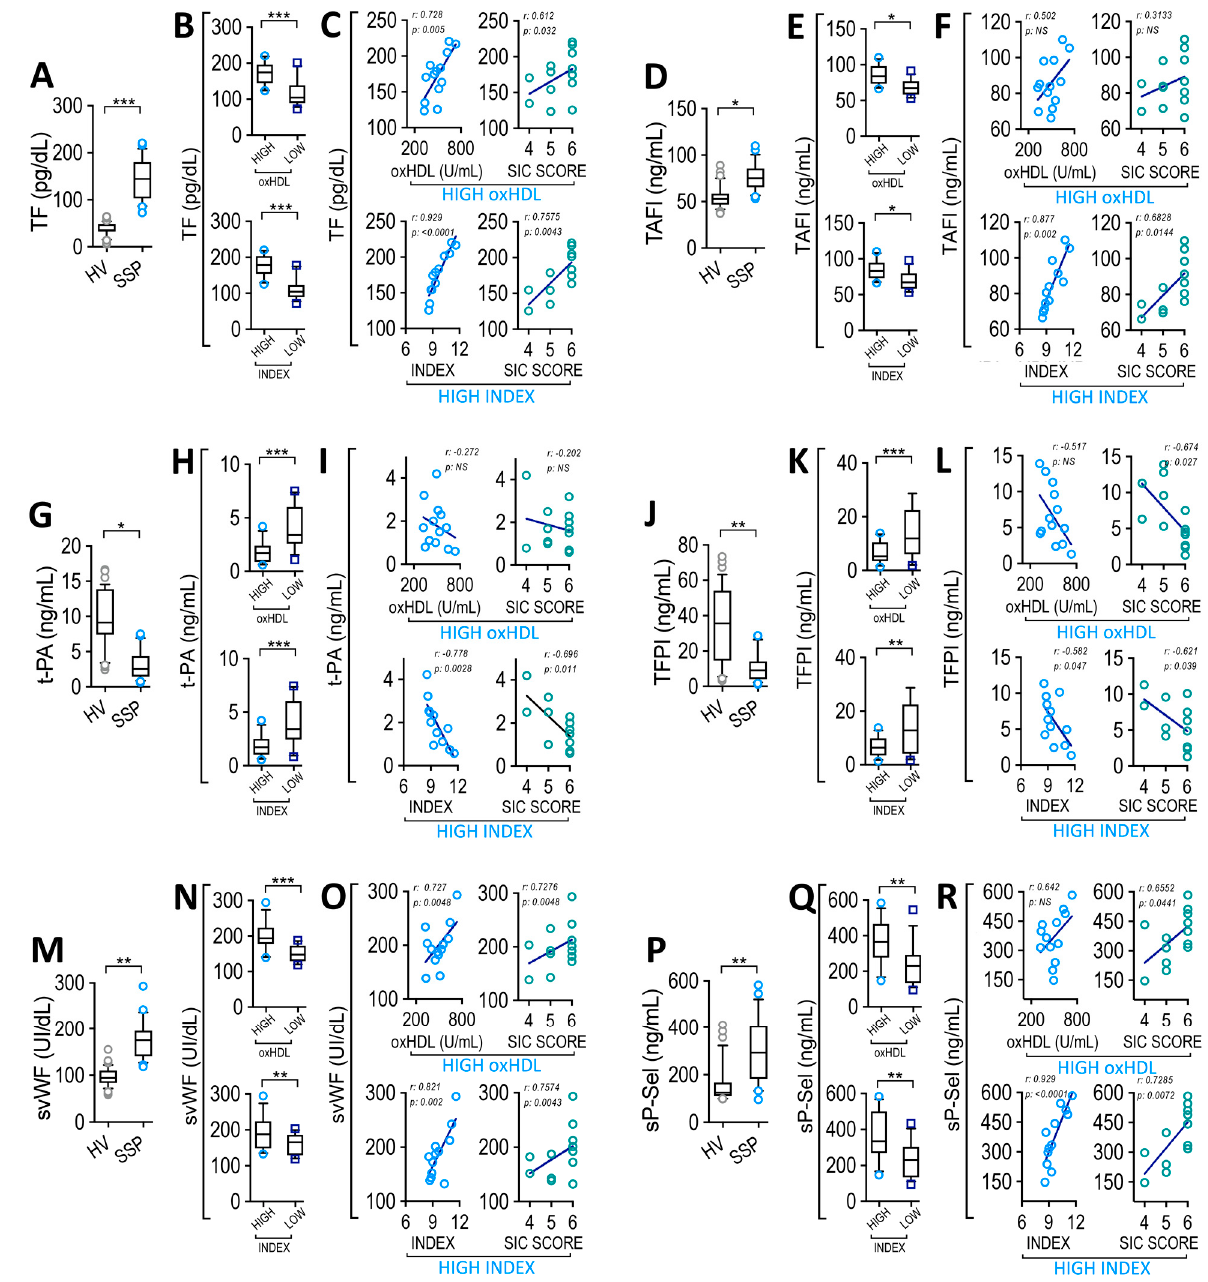
Figure 5. Plasma level of coagulation factors and soluble platelet adhesion proteins correlates with oxHDL and INDEX in SSP. Plasma level of TF ( A ), TAFI ( D ), t-PA ( G ), TFPI ( J ), svWF ( M ) and sP-Sel ( P ) in HV and SSP. Plasma level of TF ( B ), TAFI ( E ), t-PA ( H ), TFPI ( K ), svWF ( N ) and sP-Sel ( Q ) in high- and low-oxHDL and high- and low-INDEX groups from SSP. Statistical differences were assessed with student’s t -test (Mann–Whitney). * p < 0.05, ** p < 0.01, *** p < 0.001. Values are expressed as the median ± 10–90 percentile. Correlation analyses between: TP with high-oxHDL ( C , left panel, r = 0.728; p = 0.005), SIC score from high-oxHDL ( C , middle-left panel, r = 0.612; p = 0.032), high-INDEX ( C , middle-right panel, r = 0.929; p < 0.0001) and SIC score from high-INDEX ( C , right panel, r = 0.7575; p = 0.0043), TAFI with high-oxHDL ( F , left panel, r = 0.502; p = 0.08), SIC score from high-oxHDL ( F , middle-left panel, r = 0.3133; p = 0.297), high-INDEX ( F , middle-right panel, r = 0.877; p = 0.002) and SIC score from high-INDEX ( F , right panel, r = 0.6828; p = 0.0144), t-PA with high-oxHDL ( I , left panel, r = − 0.2726; p = 0.3676), SIC score from high-oxHDL ( I , middle-left panel, r = − 0.202; p = 0.509), high-INDEX ( I , middle-right panel, r = − 0.7789; p = 0.0028) and SIC score from high-INDEX ( I , right panel, r = − 0.696; p = 0.011), TFPI with high-oxHDL ( L , left panel, r = − 0.517; p = 0.071), SIC score from high-oxHDL ( L , middle-left panel, r = − 0.674; p = 0.027), high-INDEX ( L ,